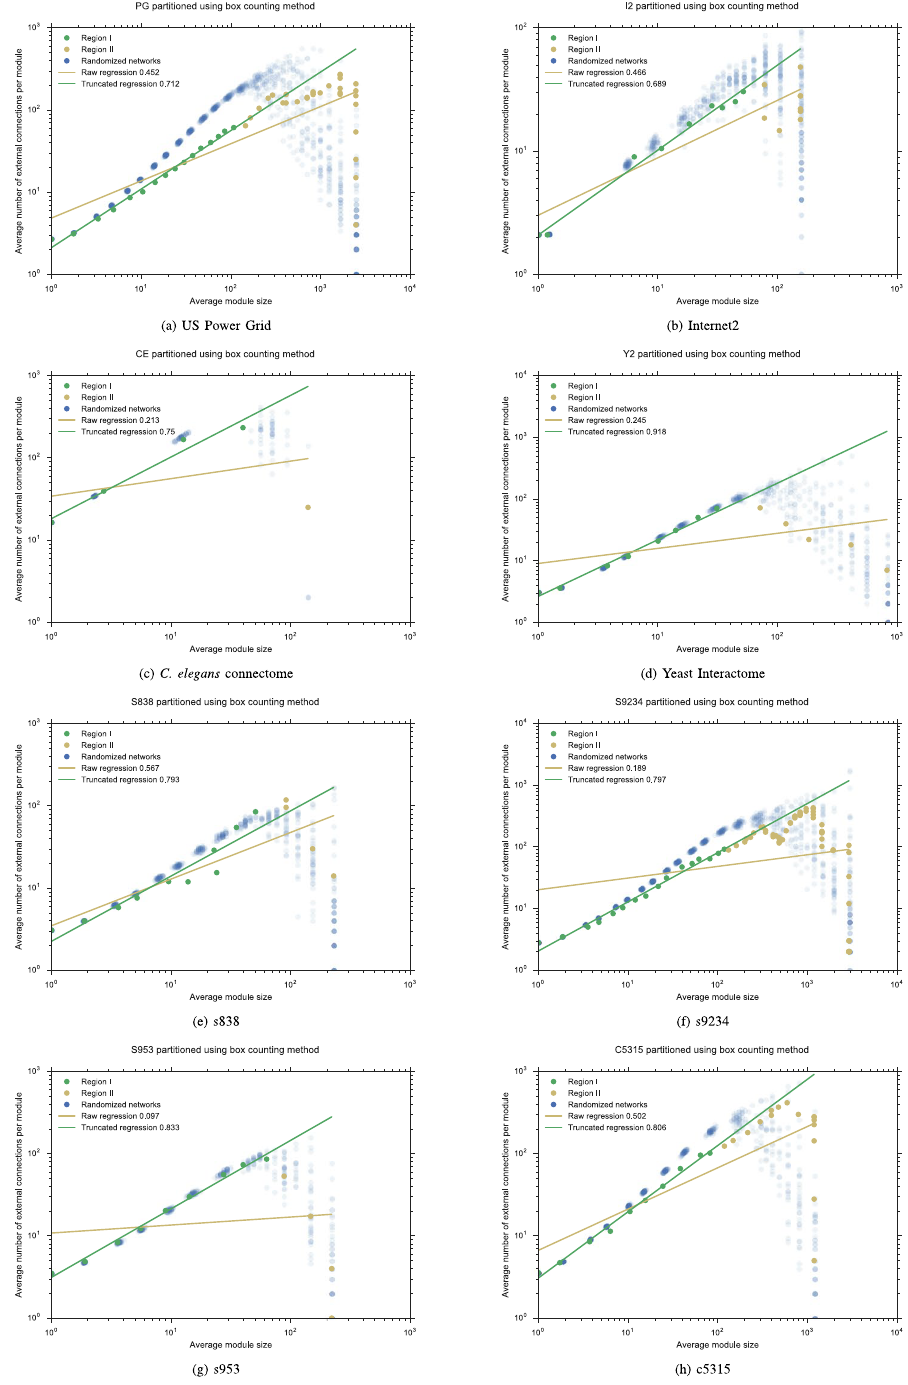
Figure 1. The box counting method is applied to procure the Rent characteristic of each network, as well the whole Rent characteristic of a sample of 50 random networks with the same degree distribution. The Rent exponent obtained by a raw regression is compared with the Rent exponent determined after truncate Region II when the coefficient of variation c in the Rentian scaling of the sample is greater than or equal to 0.1. Different results using c ≥ 0.075 have been already reported 9 (see also Table